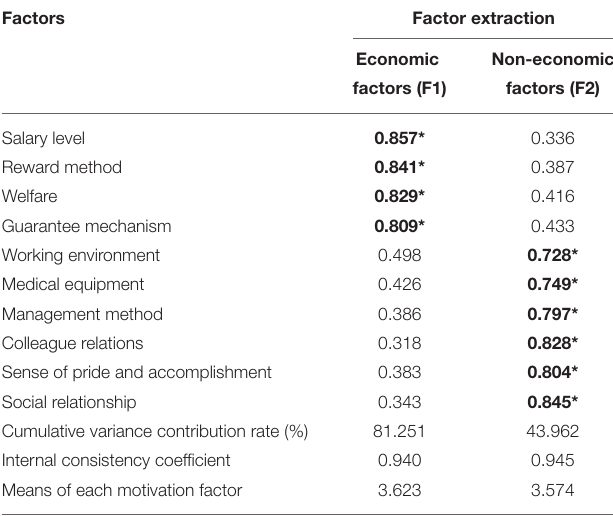
TABLE 3 | Exploratory factor analysis on the levels of various motivational